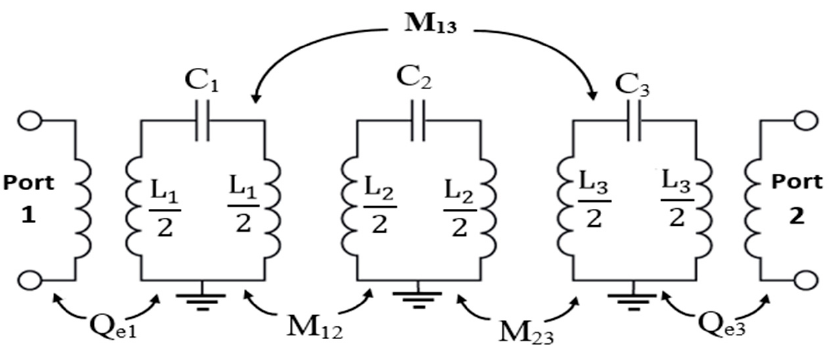
Figure 2. L-C equivalent circuit model of the presented three-pole filter. Figure 1. The geometry of the presented three-pole planar bandpass filters (BPF).